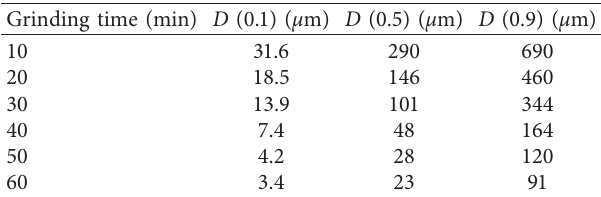
Table 2: The particle size characteristic of ground Cu-Ni slag with different grinding times.